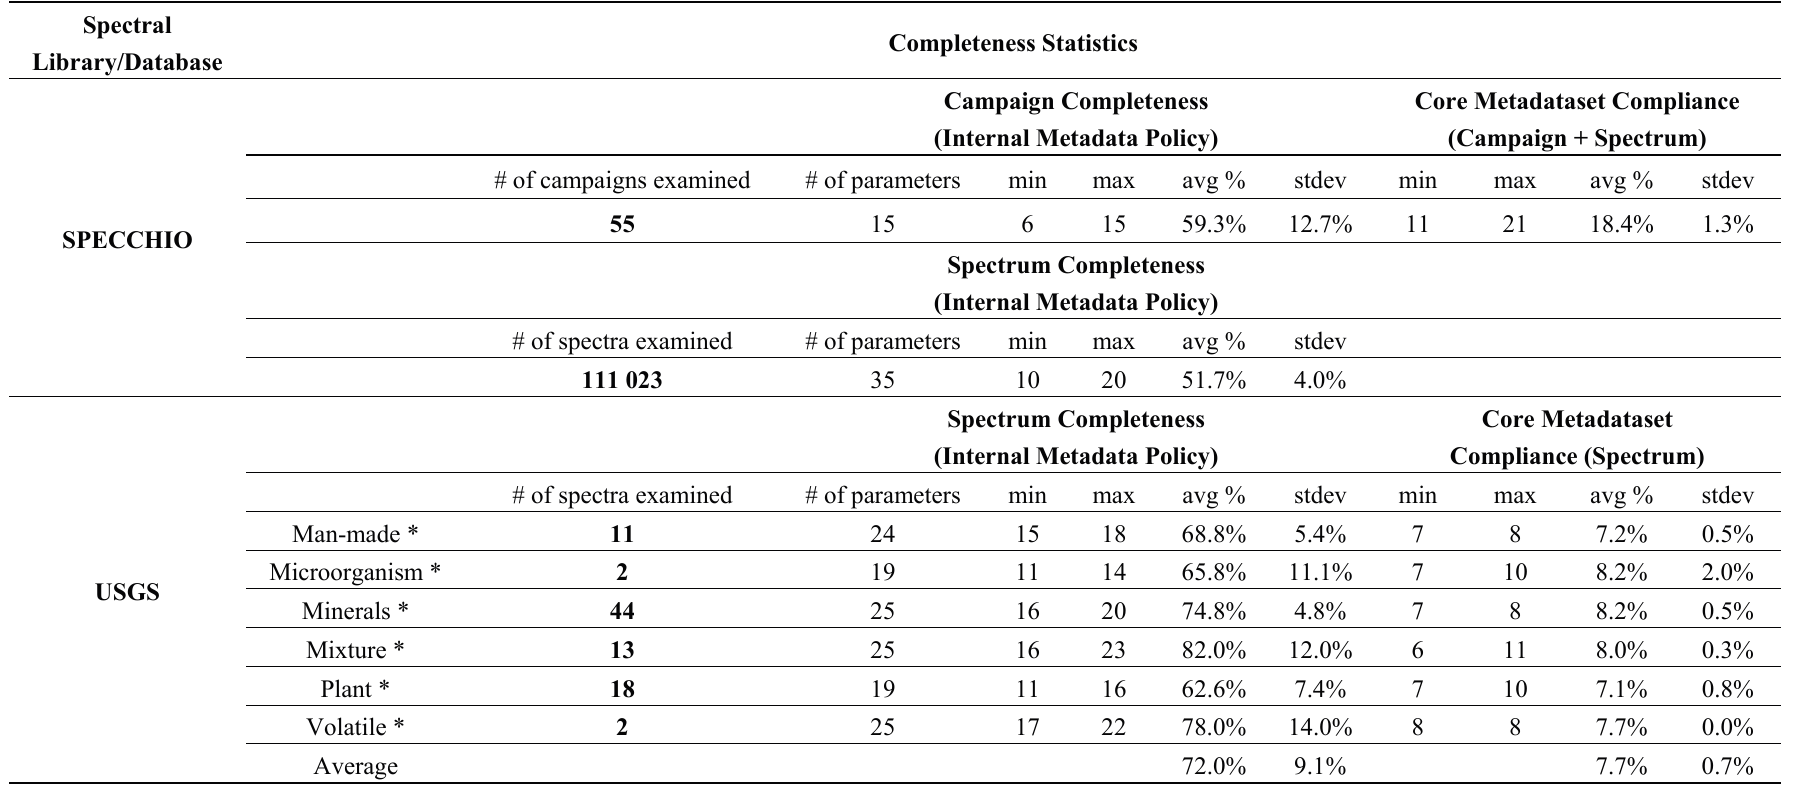
Table 4. Metadata completeness report for SPECCHIO and USGS Spectra